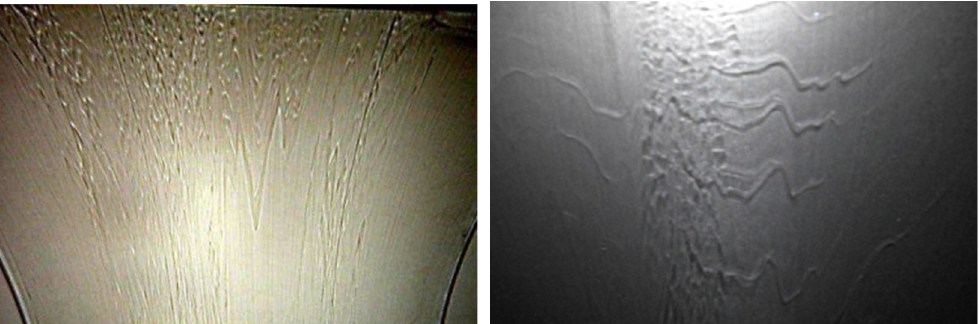
Figure 6. Typical defects observed in a coextrusion process (the flow is from top to bottom) (Reprinted from Ref. [2]).